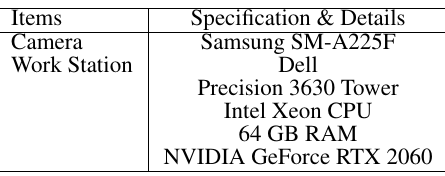
Table 2. Camera and workstation